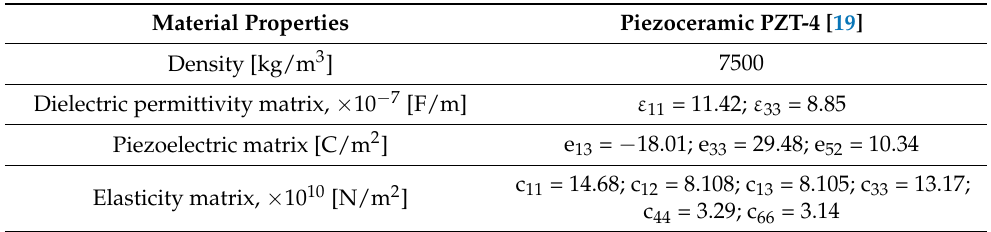
Table 1. Material properties of PZT-4. Material